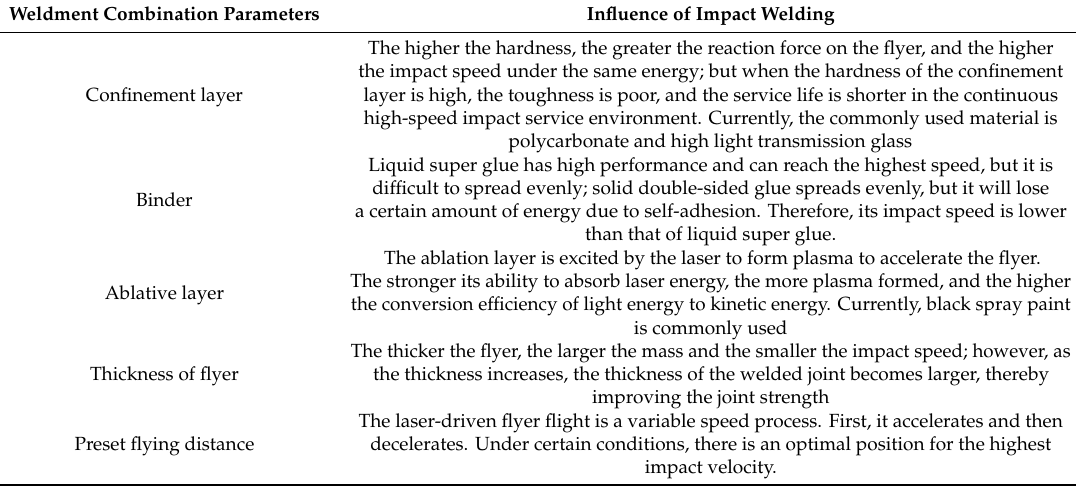
Table 1. Influence of Weldment Combination Parameters.